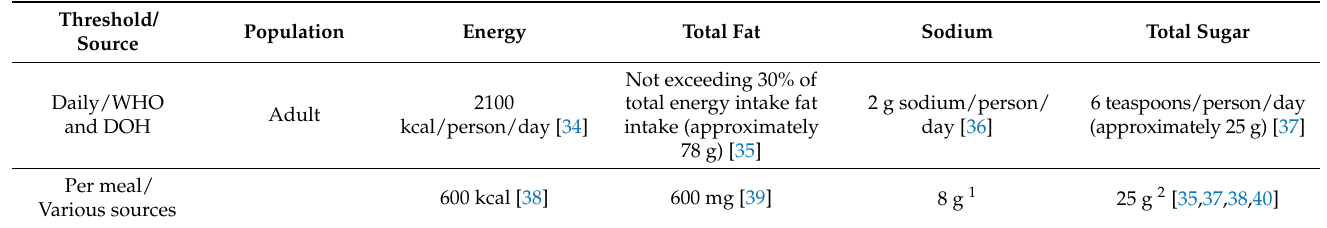
Table 1. Daily nutritional intake recommendations according to the World Health Organization and